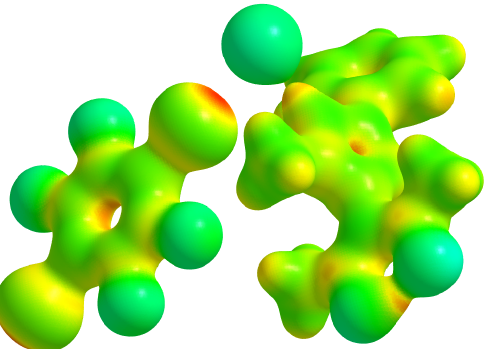
Figure 10. Electrostatic potential for 2 , mapped on an isosurface of electron density ρ = 0.05a.u. [48]; red areas are associated with a positive value (0.480a.u.), cyan areas with negative values ( − 0.0675a.u.) and green areas with an ESP